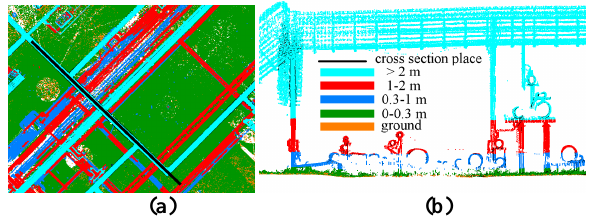
Figure 4 . The result of point cloud